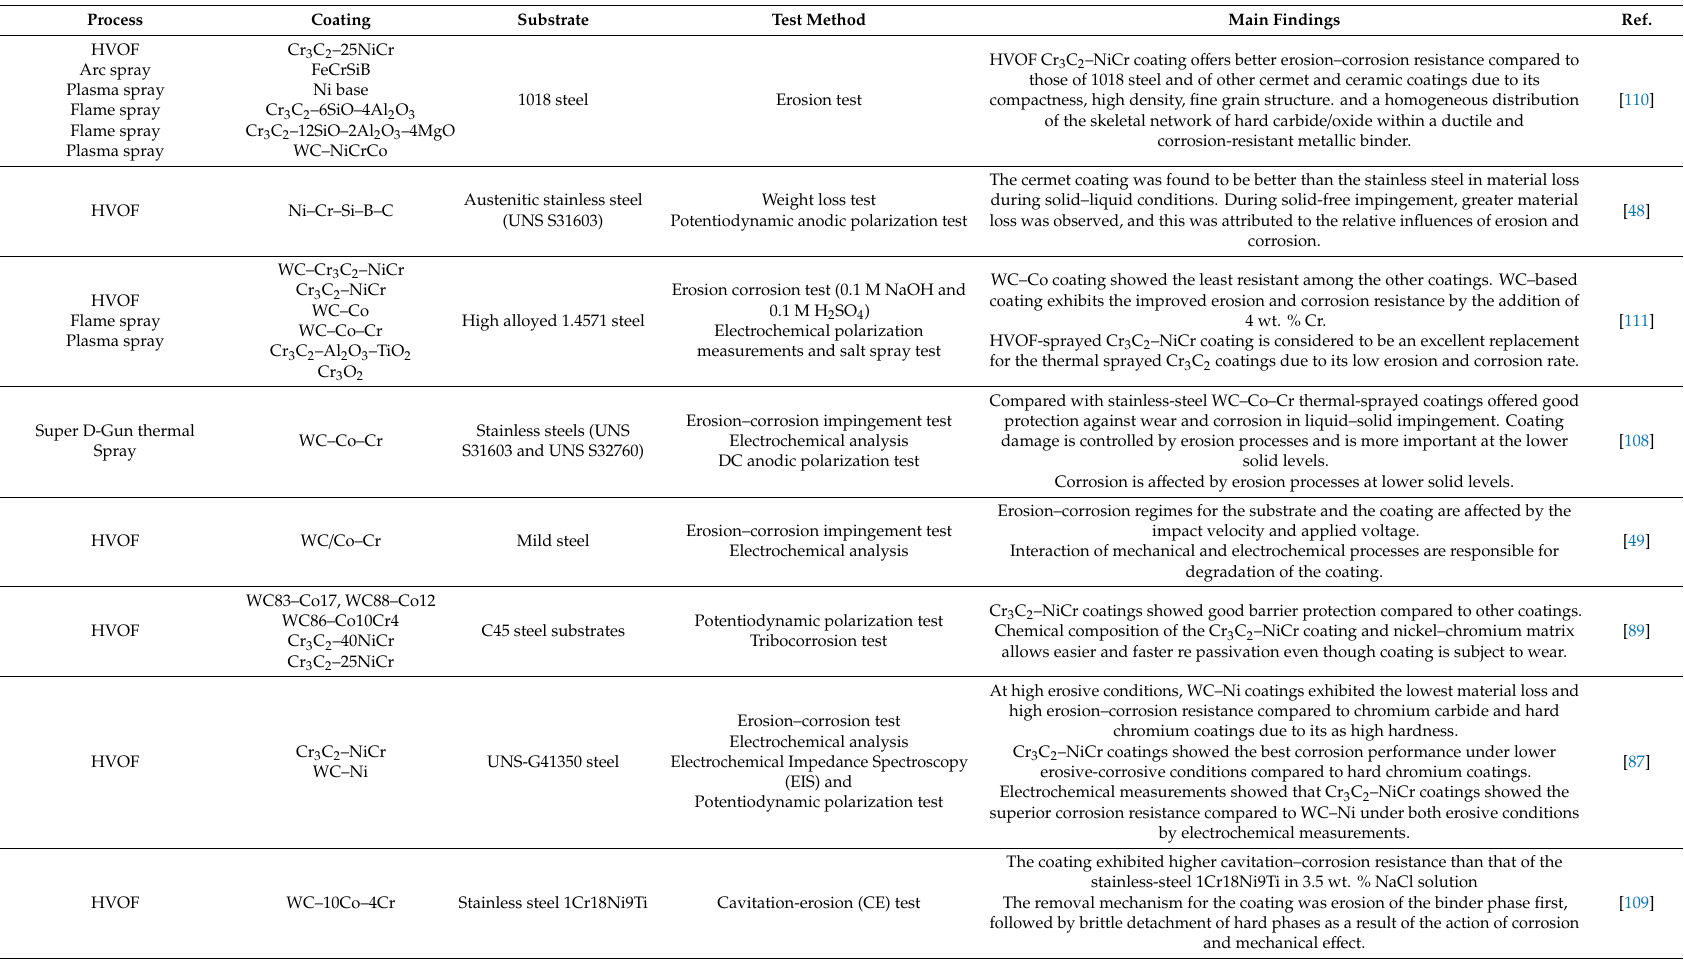
Table 2. Erosion and corrosion behavior of the various cermet